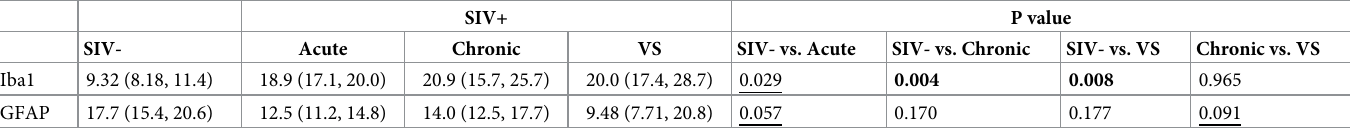
ART: antiretroviral therapy, GFAP: glial fibrillary acidic protein, Iba1: ionized calcium binding adaptor molecule 1, NHP: nonhuman primate, SIV: simian immunodeficiency virus, VS: virally suppressed Percentage of total cells (Median and interquartile range shown) P value as determined by Mann Whitney U Test (P < 0.05 statistically significant) Bold values indicate significance (P < 0.05), underlined values indicate trend (P > 0.05, <